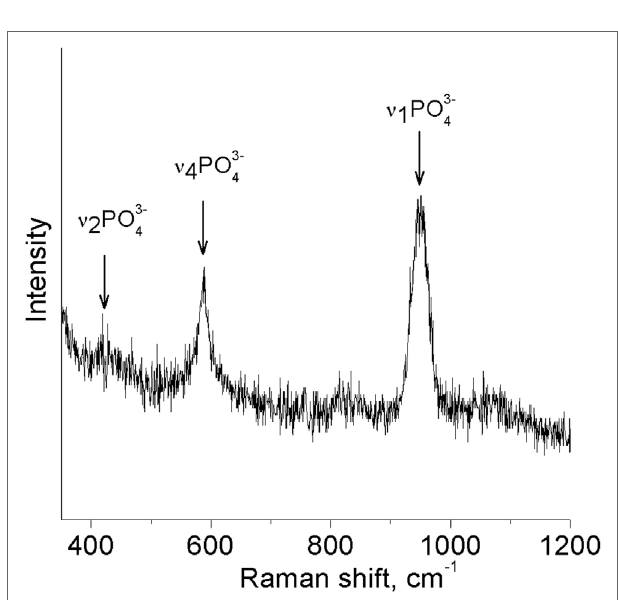
FigUre 8 | Raman spectra gathered from the surface of HA-Zn